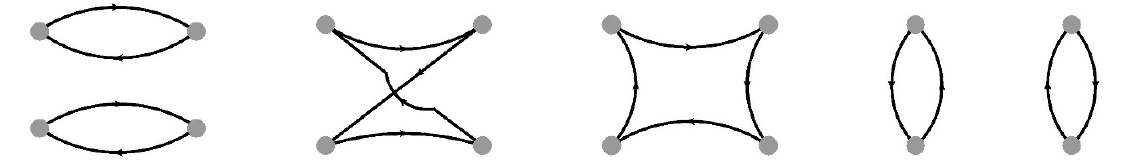
Figure 1 . (From left to right) Direct (D), crossed (C), rectangular (R) and vacuum (V) contractions in a generic (cid:25)(cid:25) scattering